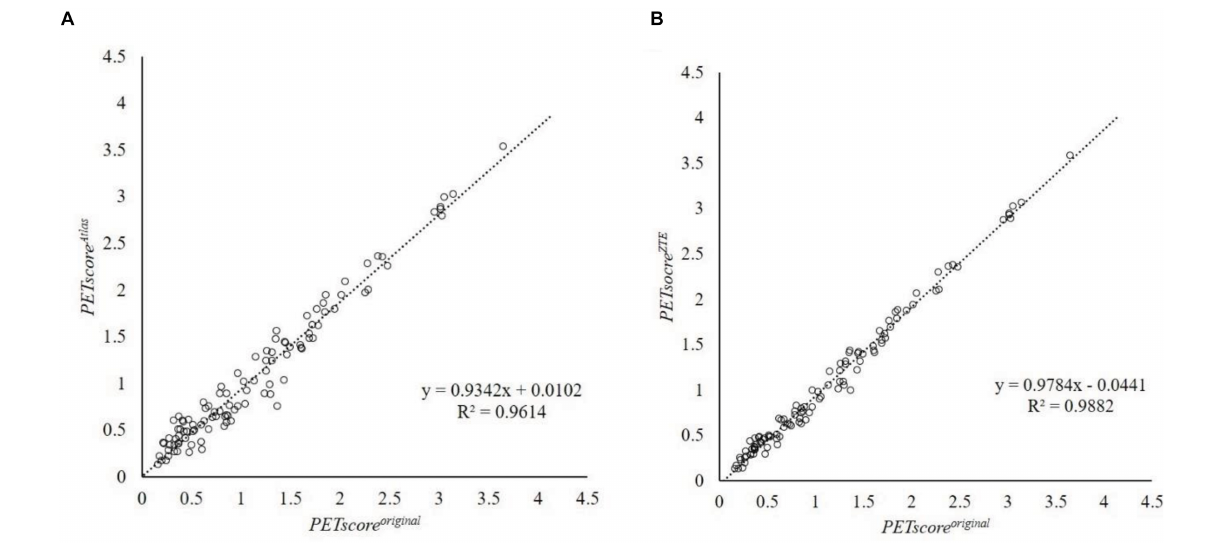
FIGURE 1 | Regression line analysis between PETscore MRAC and PETscore original . This plot shows 107 data which are averaged from 27 error maps. The horizontal axis shows PETscore original and the vertical axis shows PETscore Atlas (A) or PETscore ZTE (B) . Regression equation were y = 0.9342x + 0.0102 (A) and y = 0.9784x + 0.0441 (B) , respectively. R 2 were 0.9614 (A) and 0.9882 (B) , respectively. R 2 , coefficient of